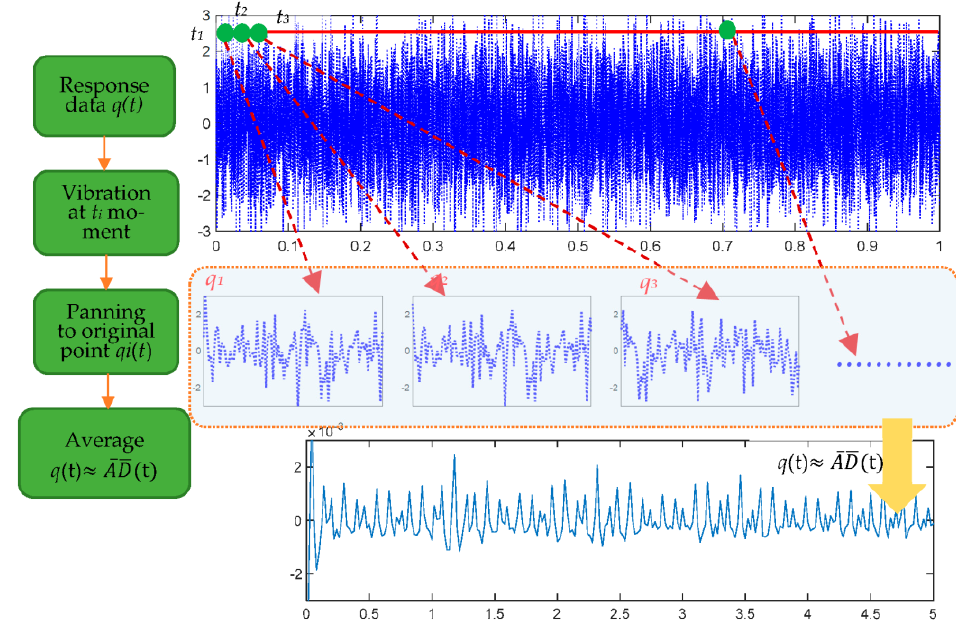
Figure 2. The RDT process.